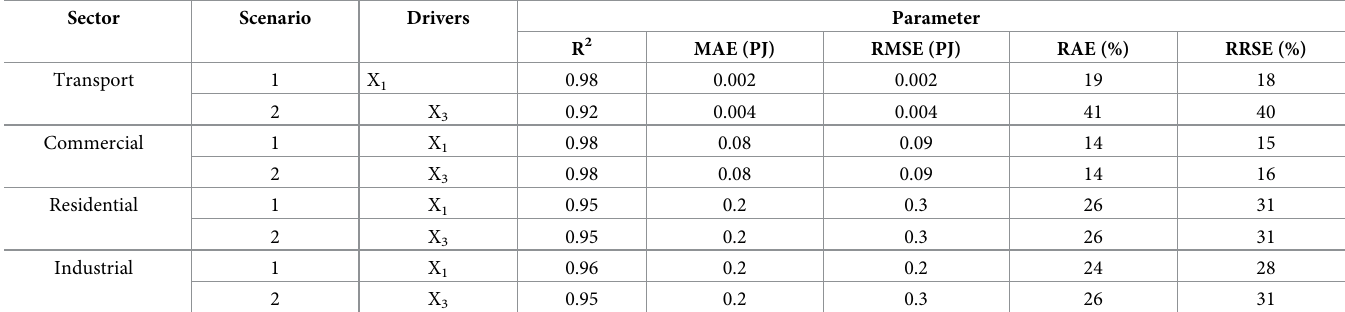
Table 8. Evaluation of scenarios used in estimation of energy consumption.